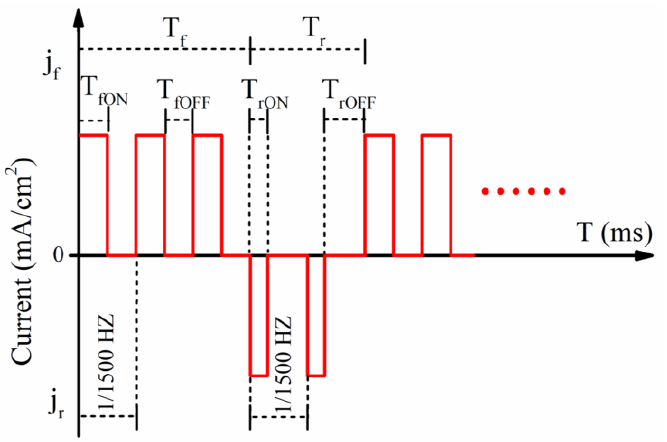
Figure 3. The schematic diagram of forward- and reverse-pulse currents to prepare tungsten-copper (W–Cu) composite coatings. Table 1. The parameters of the electroplating